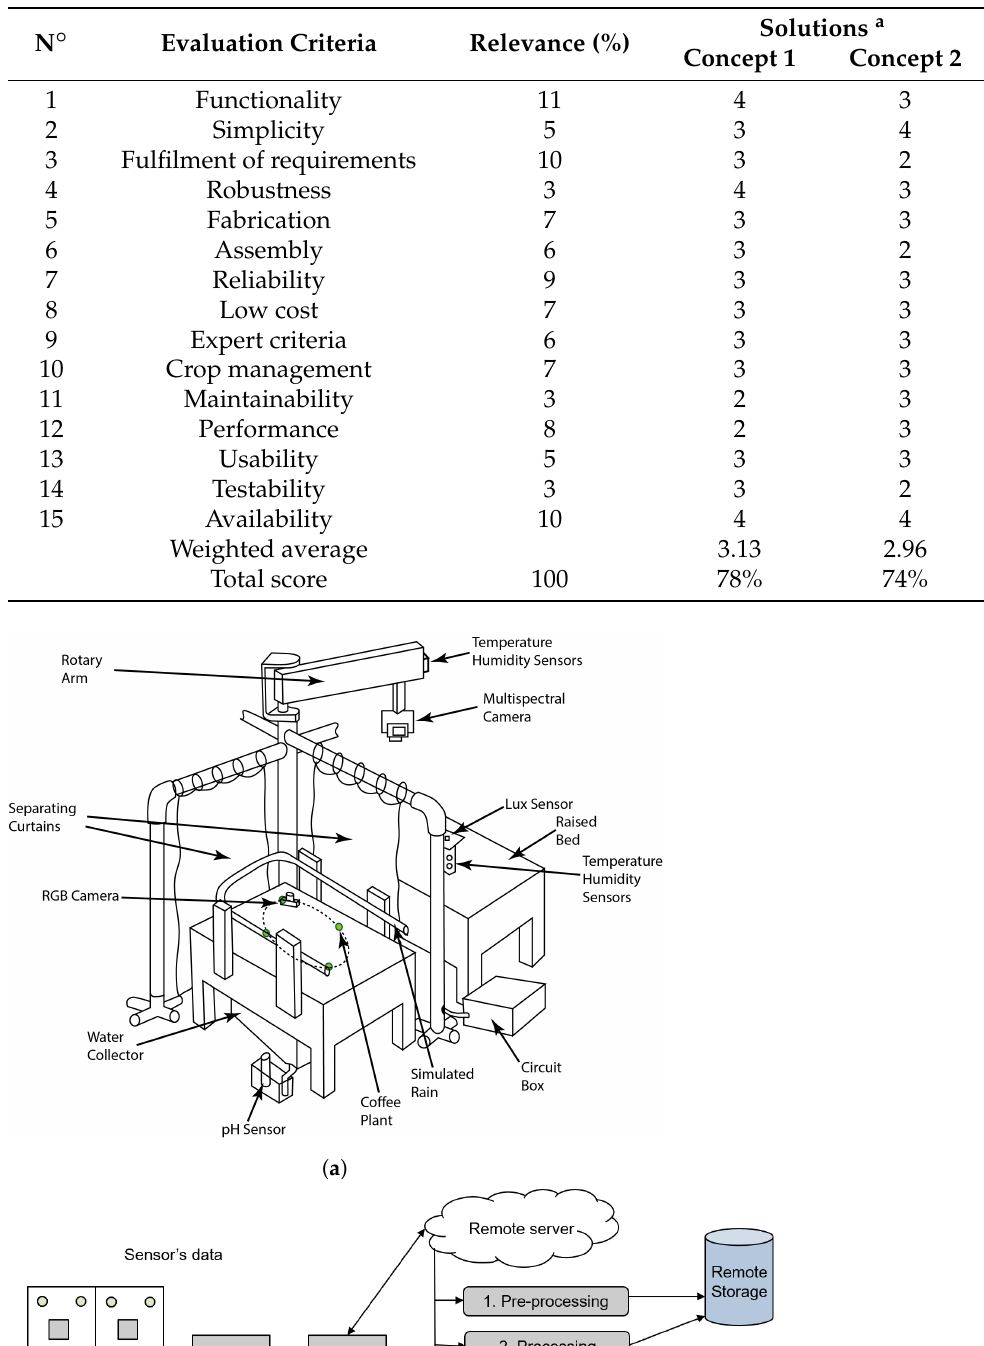
Table 1. Concept Scoring. a Value scale (score between 0–4); 0 = Not satisfied, 1 = Acceptable, 2 = Sufficient, 3 = Good, 4 = Totally satisfied.